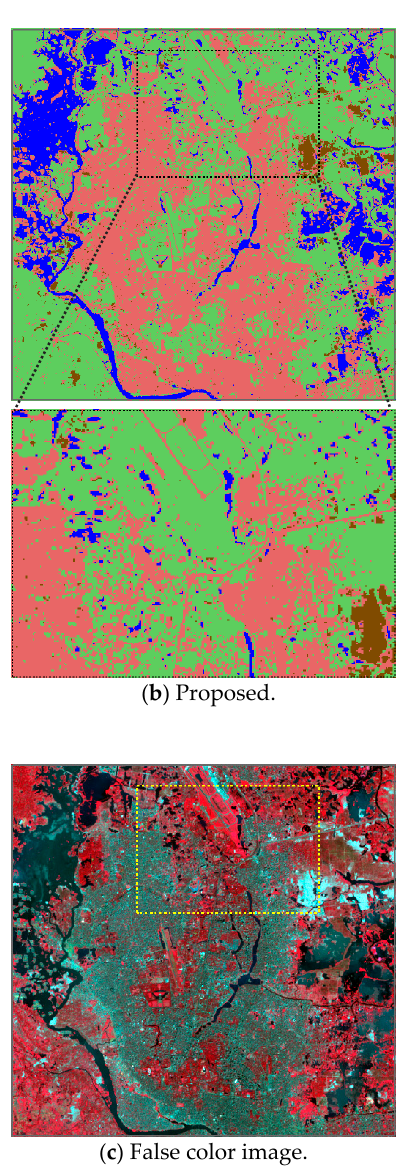
Figure 16. Classification of land cover in Hong Kong.